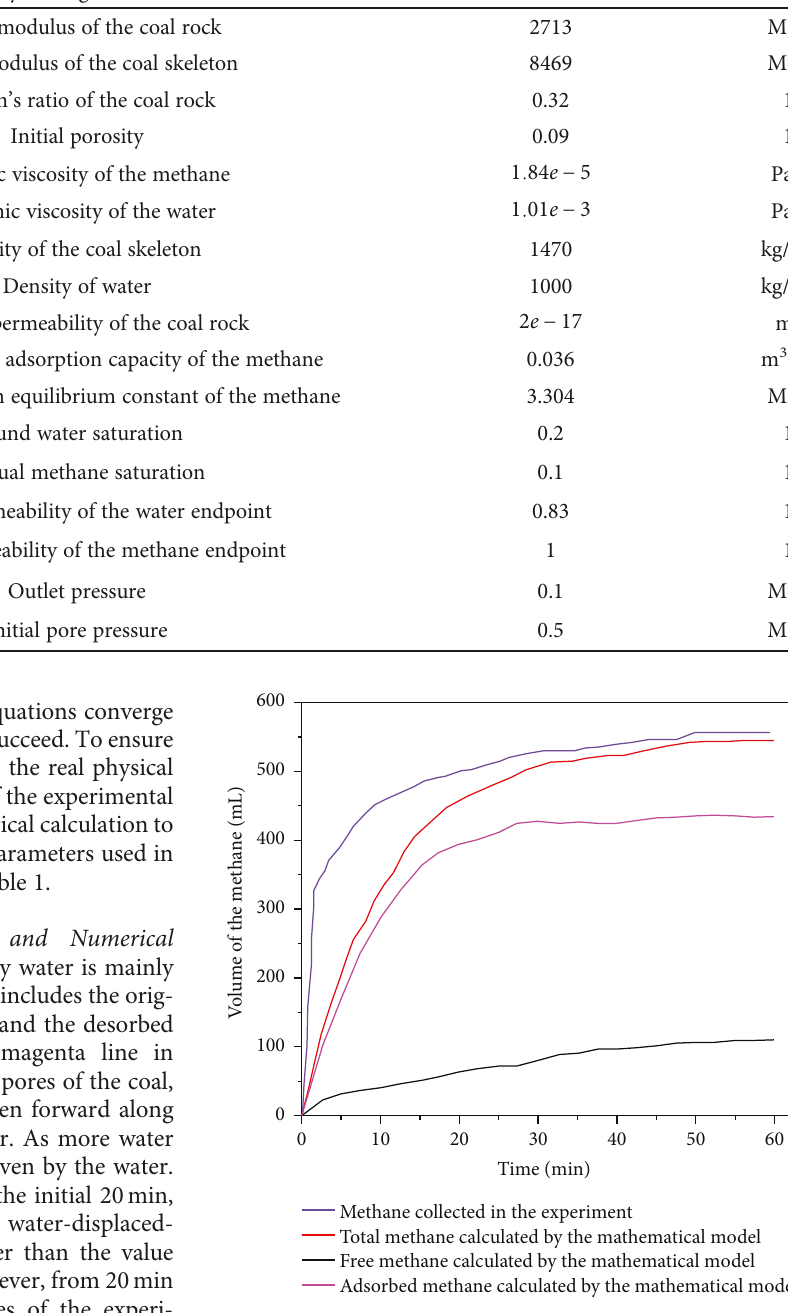
Figure 7: Change in the methane volume over